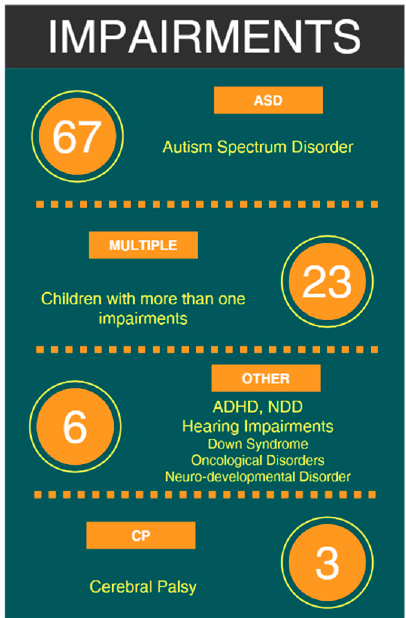
Figure 6. Number of applications of robots on different kind of impairments.